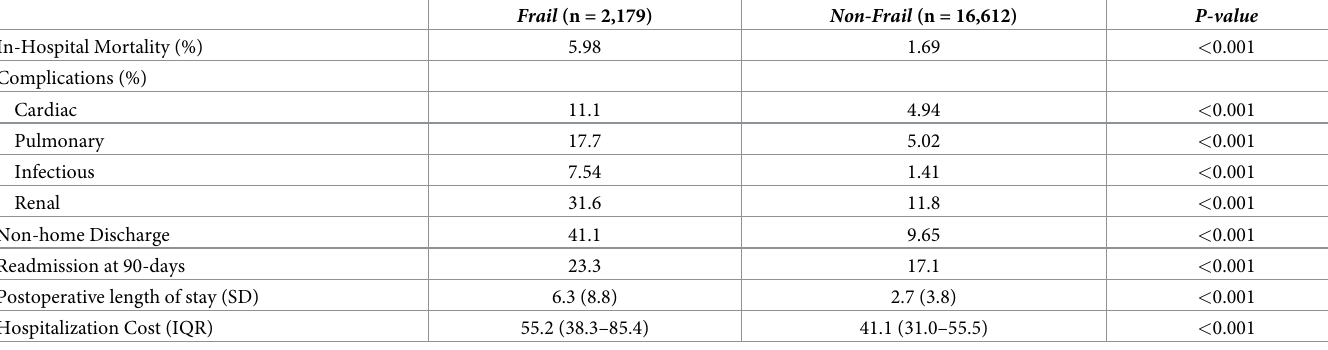
Table 2. Unadjusted outcomes of patients undergoing TMVR from 2016–2018 by frail and non-frail cohorts.